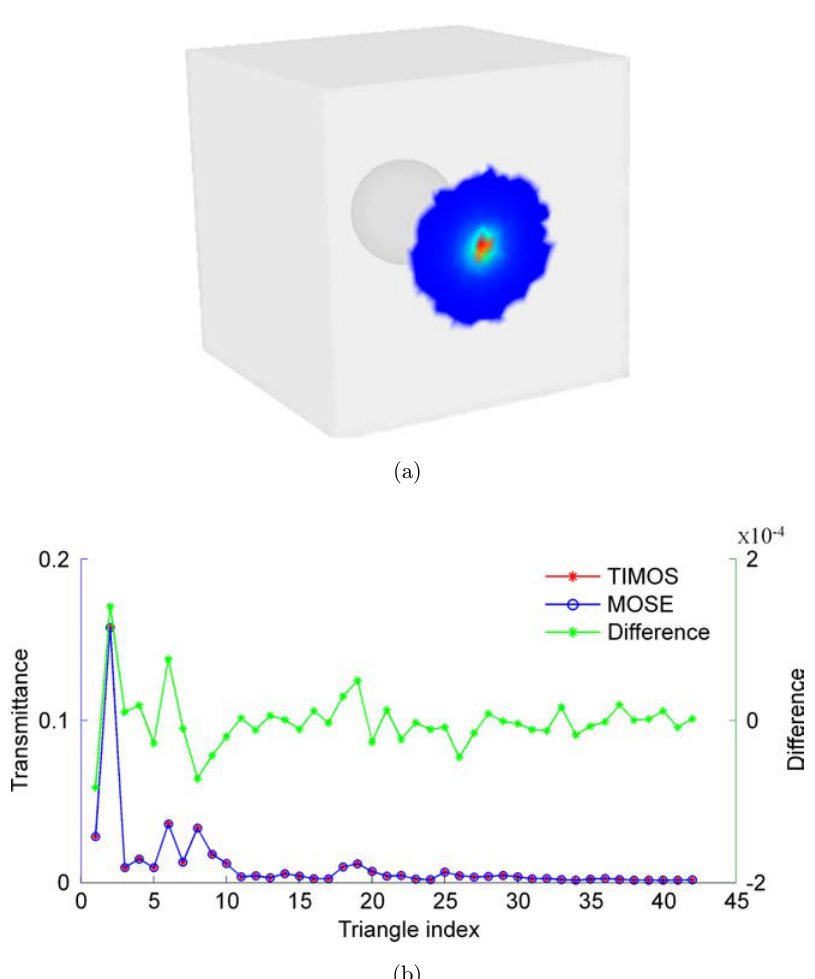
Fig. 5. Comparisons of the transmittance between the TIMOS and MOSE in case of regular-shaped phantom. (a) The trans- mittance result of MOSE. (b) Comparison of the transmittance between TIMOS and